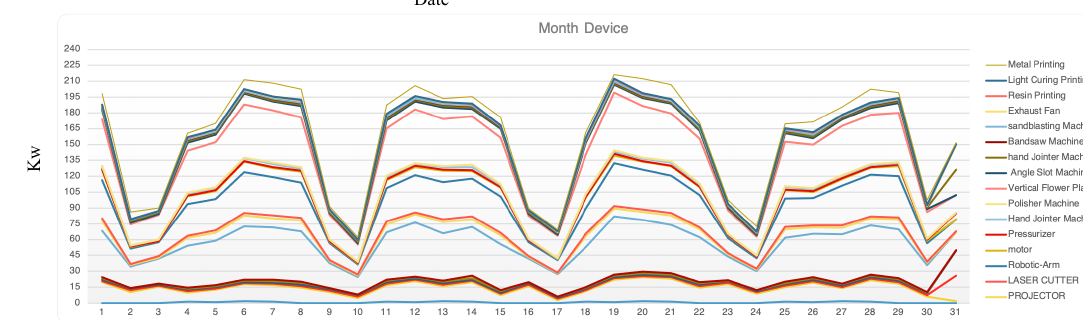
Figure 8. Monthly usage of every device.